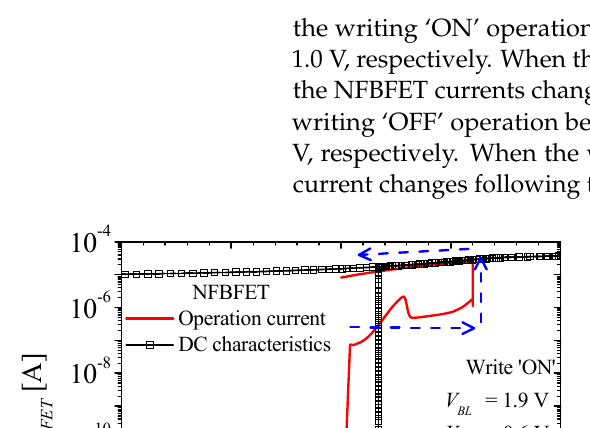
Table 2. The M3D − FBFET − SRAM cell operation voltages.